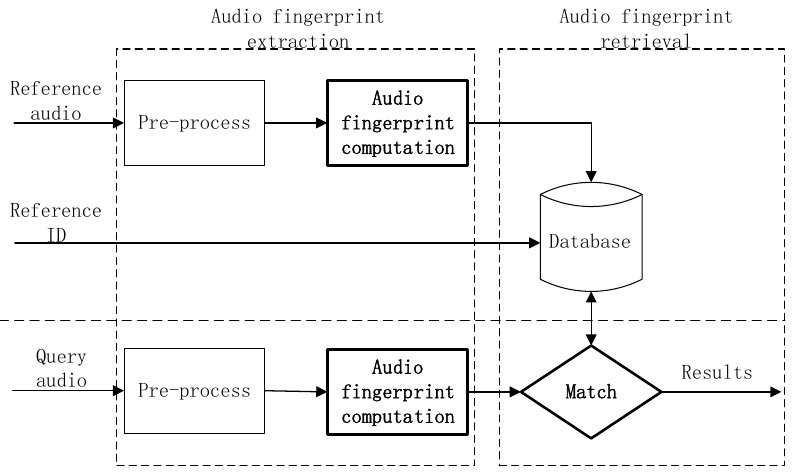
Figure 1. Audio fingerprinting system framework.